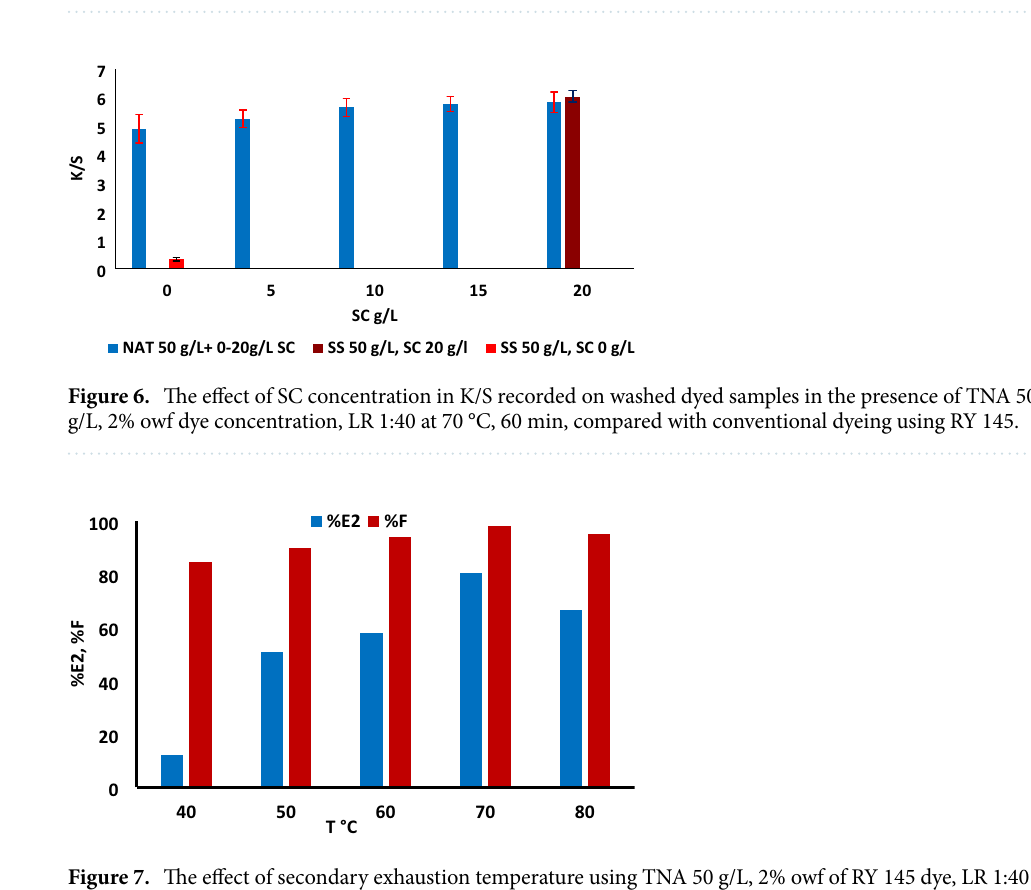
Table 3. The effect of sodium carbonate concentration in color data for RY 145 varied from 0 to 20 g/L while using 50 g/L TNA. The reference sample represents the conventional dyeing method, and last raw present the dyed sample with SS instead of TNA and 0 g/L SC. Reference: The dyed sample with conventional method using 50 g/L SS and 20 g/L SC.